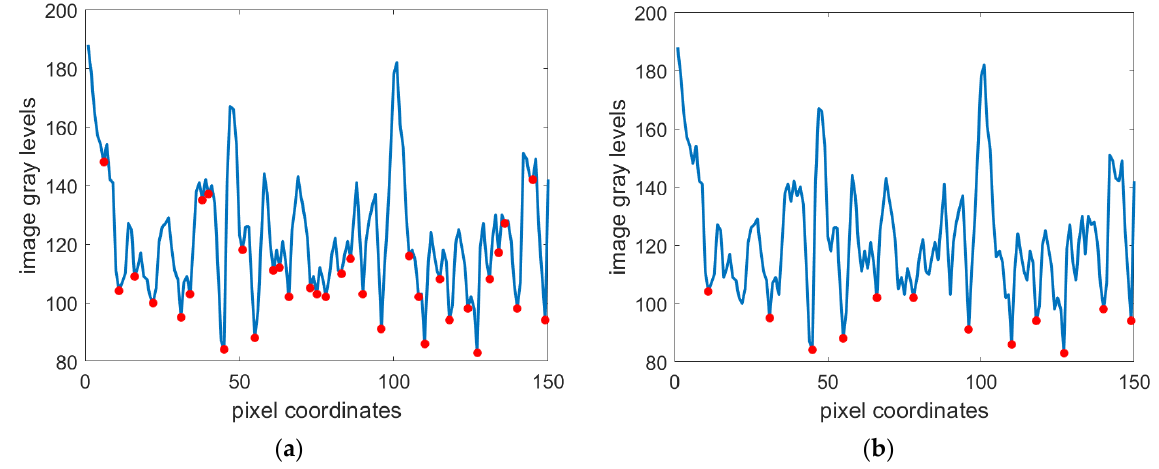
Figure 3. The curve of the grey levels of the pixel column of fragment 2 (with obvious fatigue striations) in the image shown in Figure 1, with the local minima highlighted in red after the first ( a ) and second ( b ) iterations. A binary image 𝐵 was obtained (Figure 4a) after applying the operation of locating the local minima to all columns of the image. The gaps in the lines corresponding to the striations were eliminated by applying the morphological dilation operation to binary image 𝐵 with a structural element 𝑆 in the form of a square with a size of 3 × 3 pixels [61]. As a result, 𝐵⨁𝑆 is defined as: